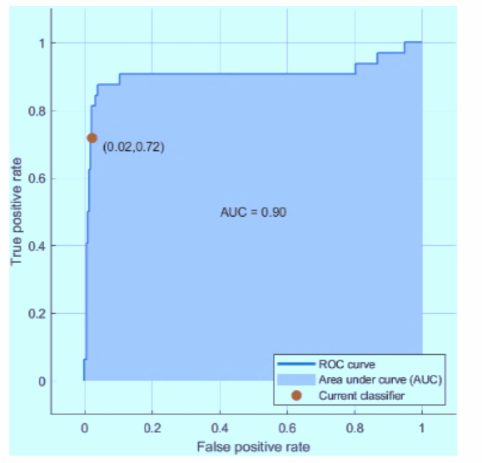
Figure 14. Receiver operating characteristic (ROC) curve for the support vector machine.